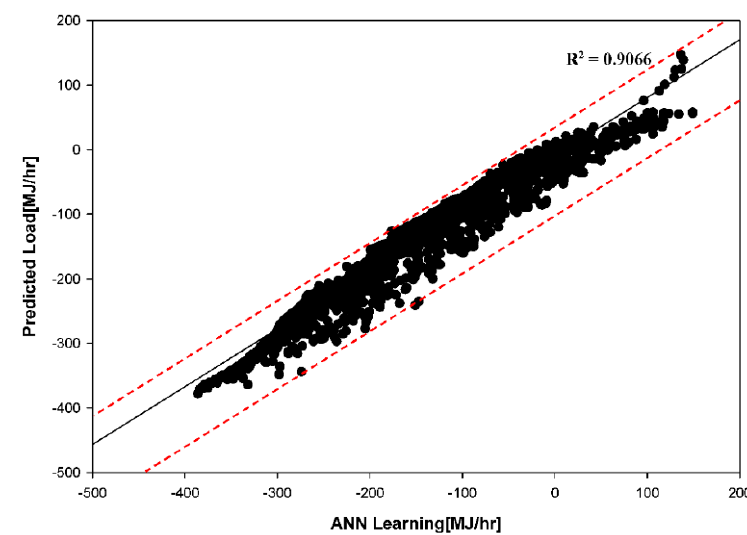
Figure 7. Relationship between the indoor load and predicted load.